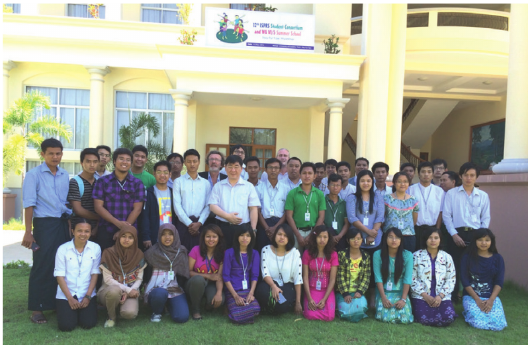
Figure 3. Group photo at the 2014 Myanmar summer school.